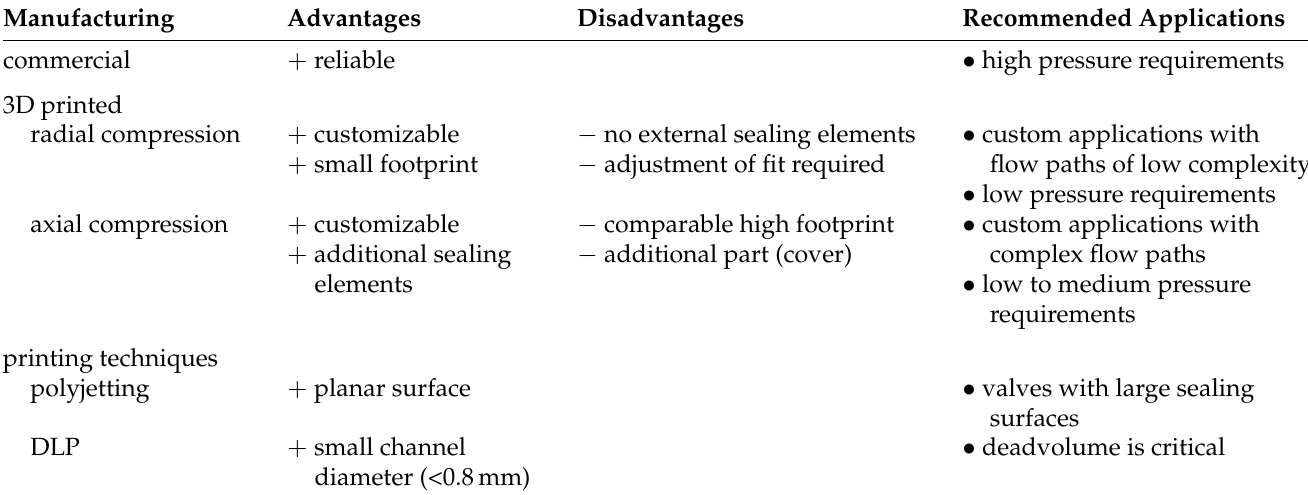
Table 2. Comparison of different valve designs (DLP: digital light